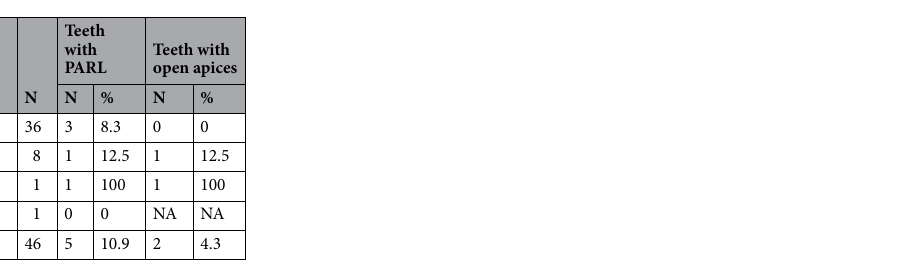
Table 3. Frequencies and percentages of PARLs and open apices according to DI type. NA Not